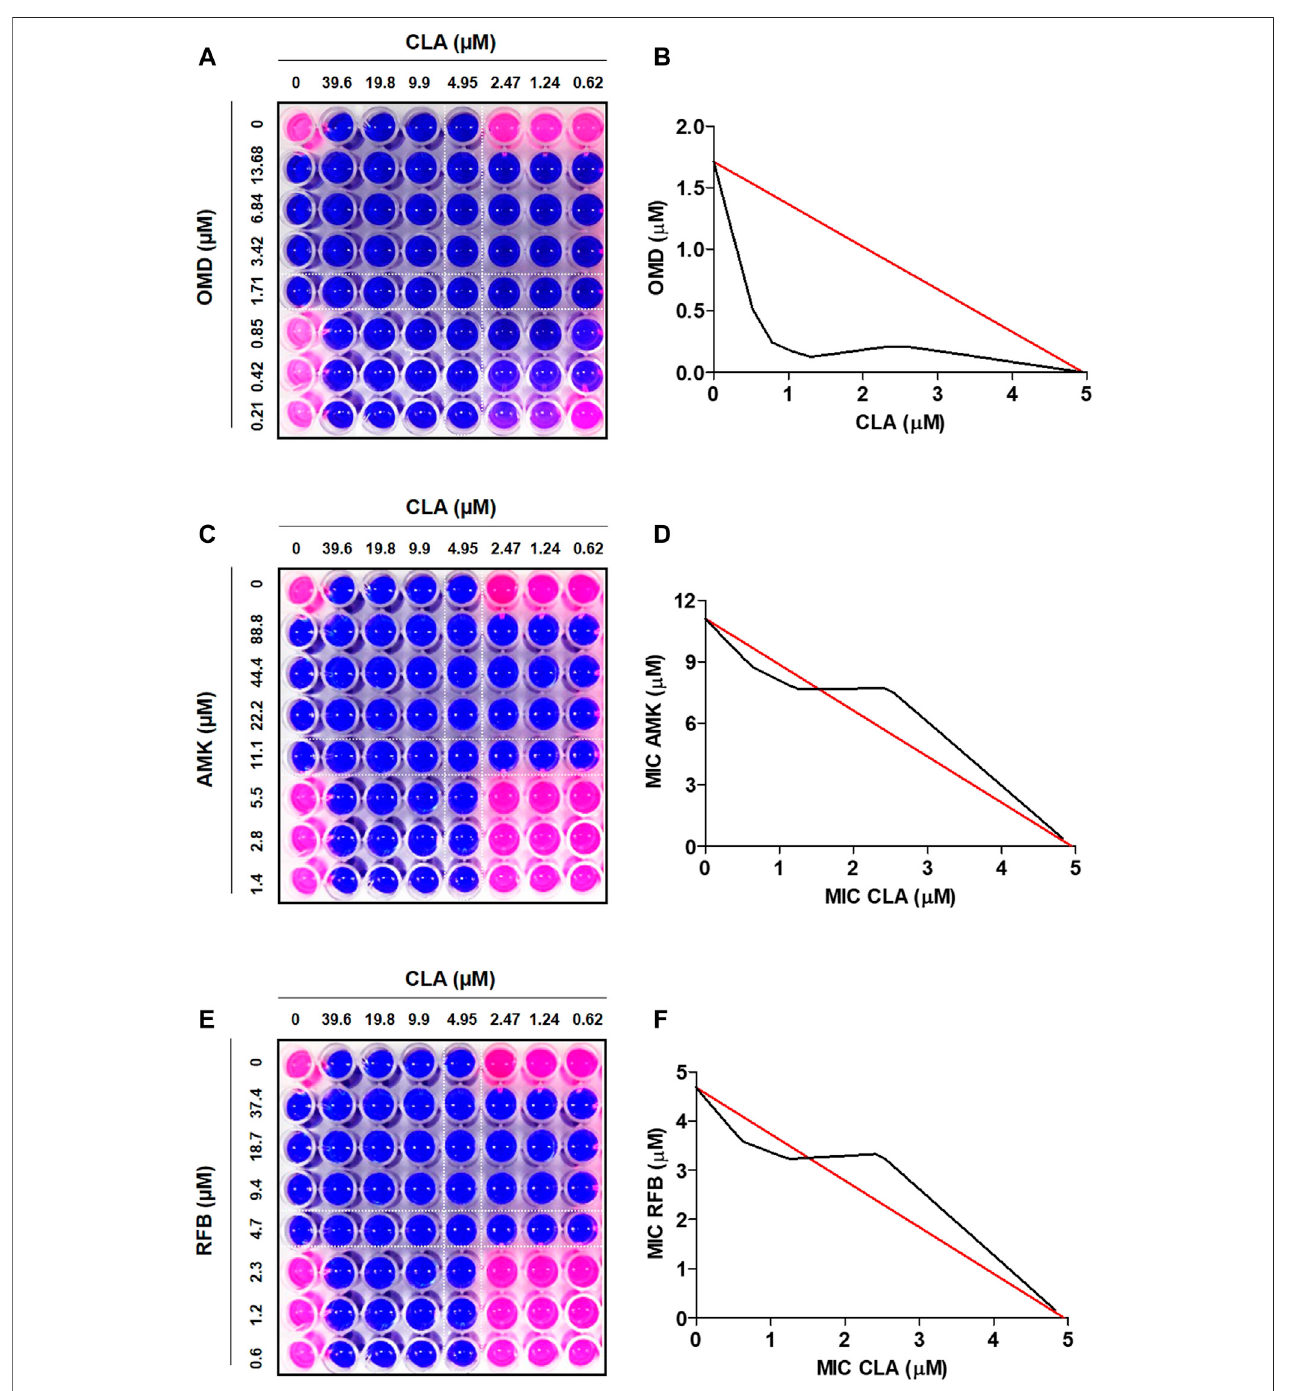
FIGURE 1 | Drug-drug interaction using checkerboard assay. Drug interaction was evaluated in MIC 50 , one-half the MIC 50 , one-quarter the MIC 50 , one half of one quarter the MIC 50 of CLA (horizontal) in combination with MIC 50 , one-half the MIC, one-quarter the MIC 50 , one half of one quarter the MIC 50 of OMD (A) , AMK (C) , and RFB (E) . Isobolograms of the resazurin checkerboard synergy testing method showing synergy of CLA with OMD (B) . The additive effect observed when CLA interact with AMK (D) and RFB (F) . The white line indicates MIC 50 value of each compound.